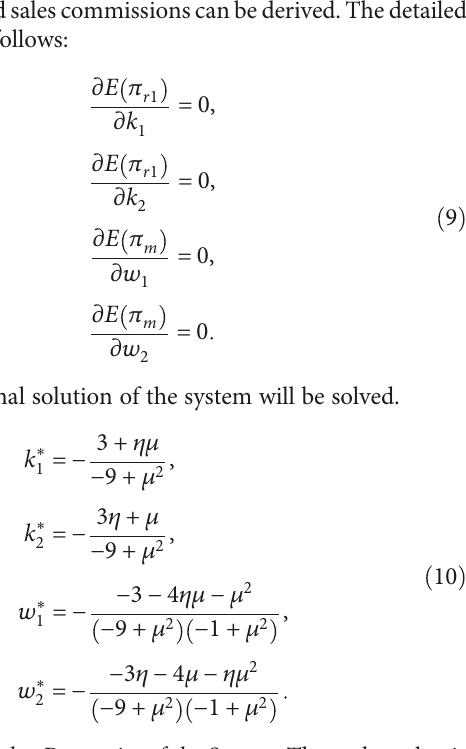
Figure 1: The model of supply